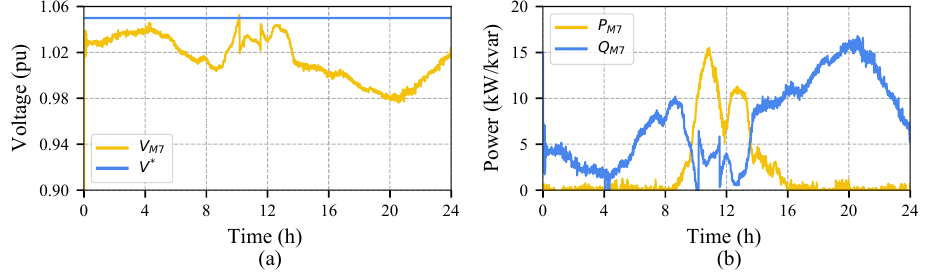
Figure 14. PSHIL-3. ( a ) 24-h evolution of voltage in bus M7. ( b ) 24-h evolution of PV active and reactive power injections in bus